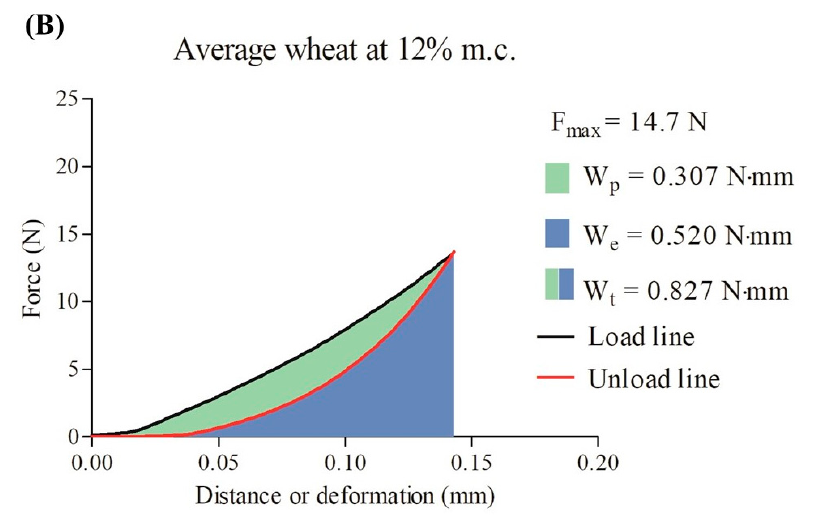
Figure 3. Force–deformation curves obtained from the uniaxial compression test at small deformation (5%) of the kernels at different moisture contents: ( A ) 16% and ( B ) 12%. m.c.: moisture content; F max : maximum force; W p : plastic work; W e : elastic work; W t : total work.